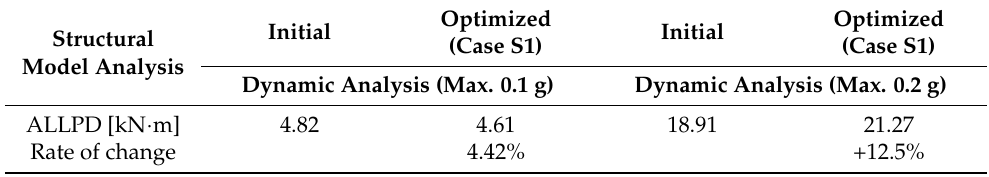
Table 2. Energy dissipation of each optimized shape with a structure under dynamic loading.